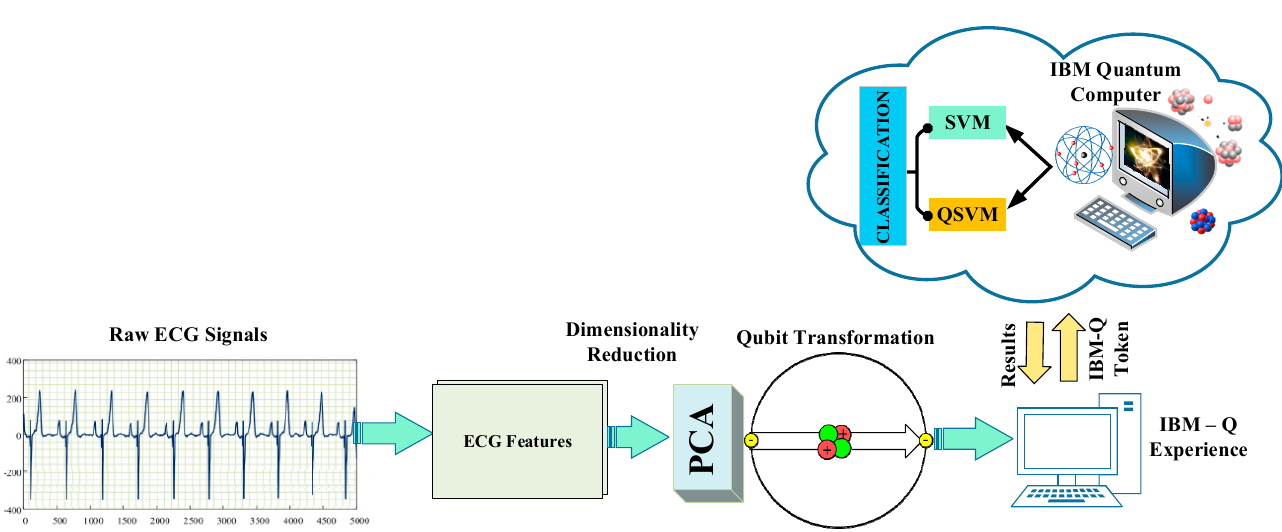
Figure 1. Illustration of the proposed methods.